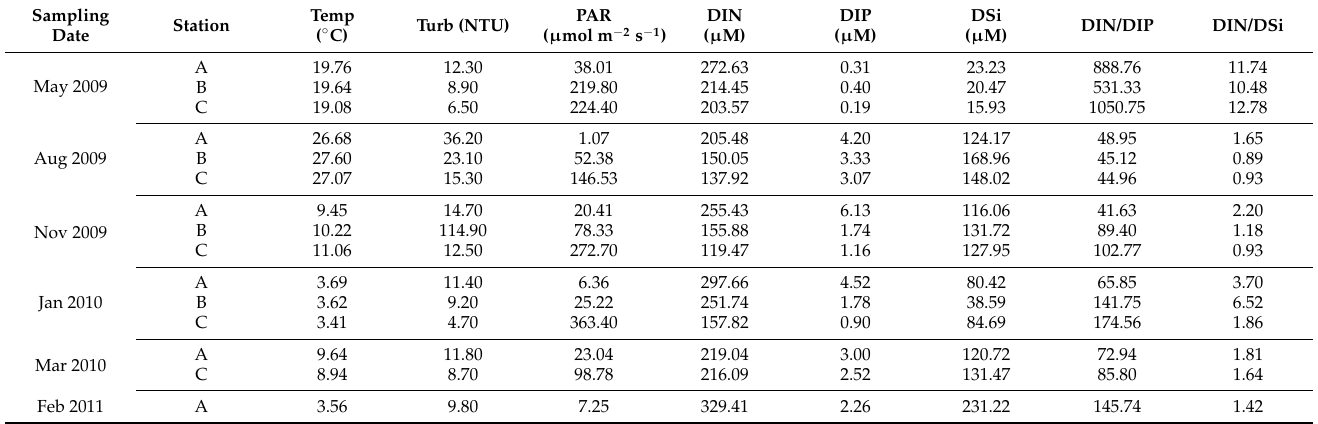
Table 1. Physical properties of, and nutrient concentrations in surface water at the sampling stations (Sts A, B, and C) in the freshwater zone of the Yeongsan River estuary: Temp, water temperature; Turb, turbidity; PAR, photosynthetically active radiation at 1.1 m; DIN, dissolved inorganic nitrogen (NO 2 −